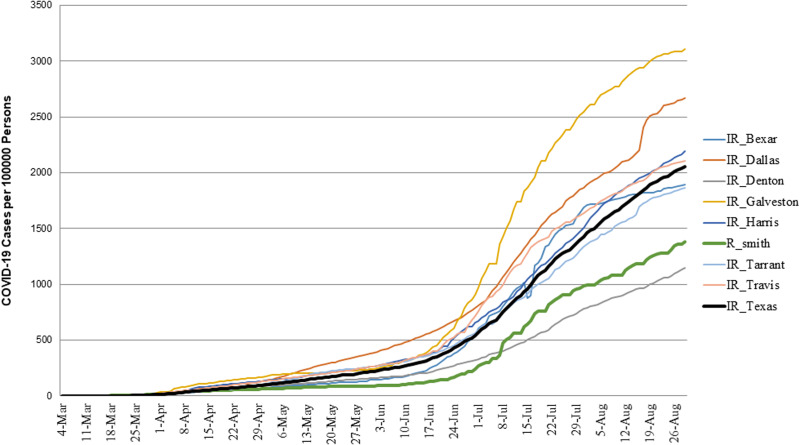
Comparison of daily cumulative incidence rate in selected counties in Texas. The figure shows a comparison of COVID-19 incidence rate in Smith County (green curve) and compared to other counties in Texas, including rural and urban counties, and overall incidence COVID-19 trajectory in State of Texas (black curve).